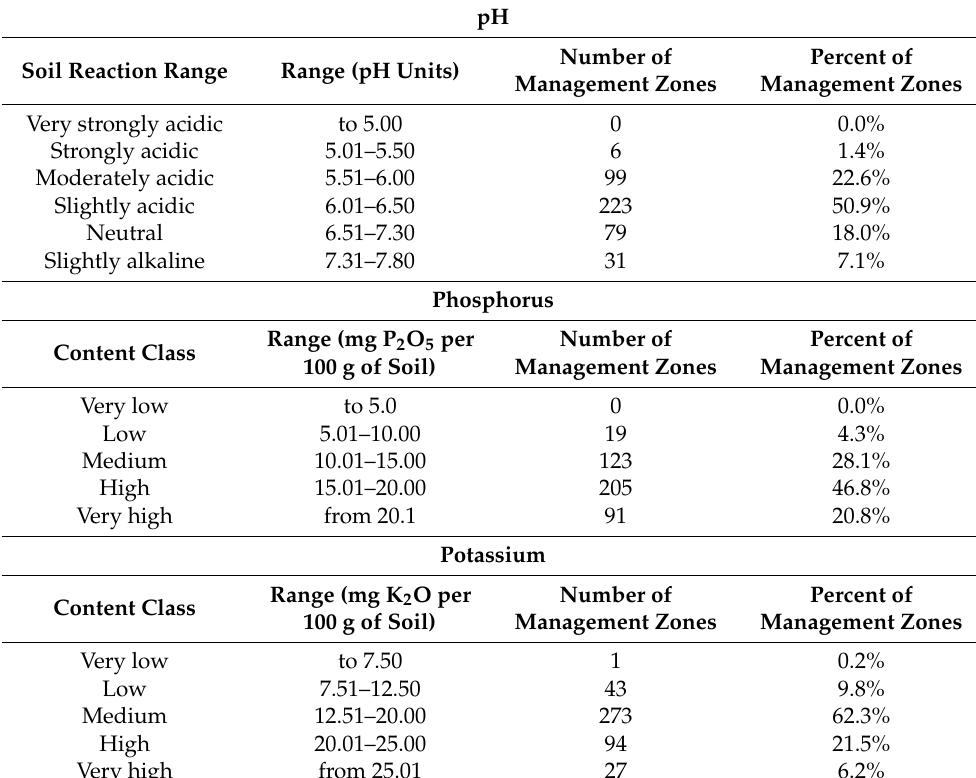
Table 2. Number and percentage of managements zones for different classes of soil pH and content of nutrients [46,47] (available forms of phosphorus, potassium, and magnesium) based on averaged data for all three years of study